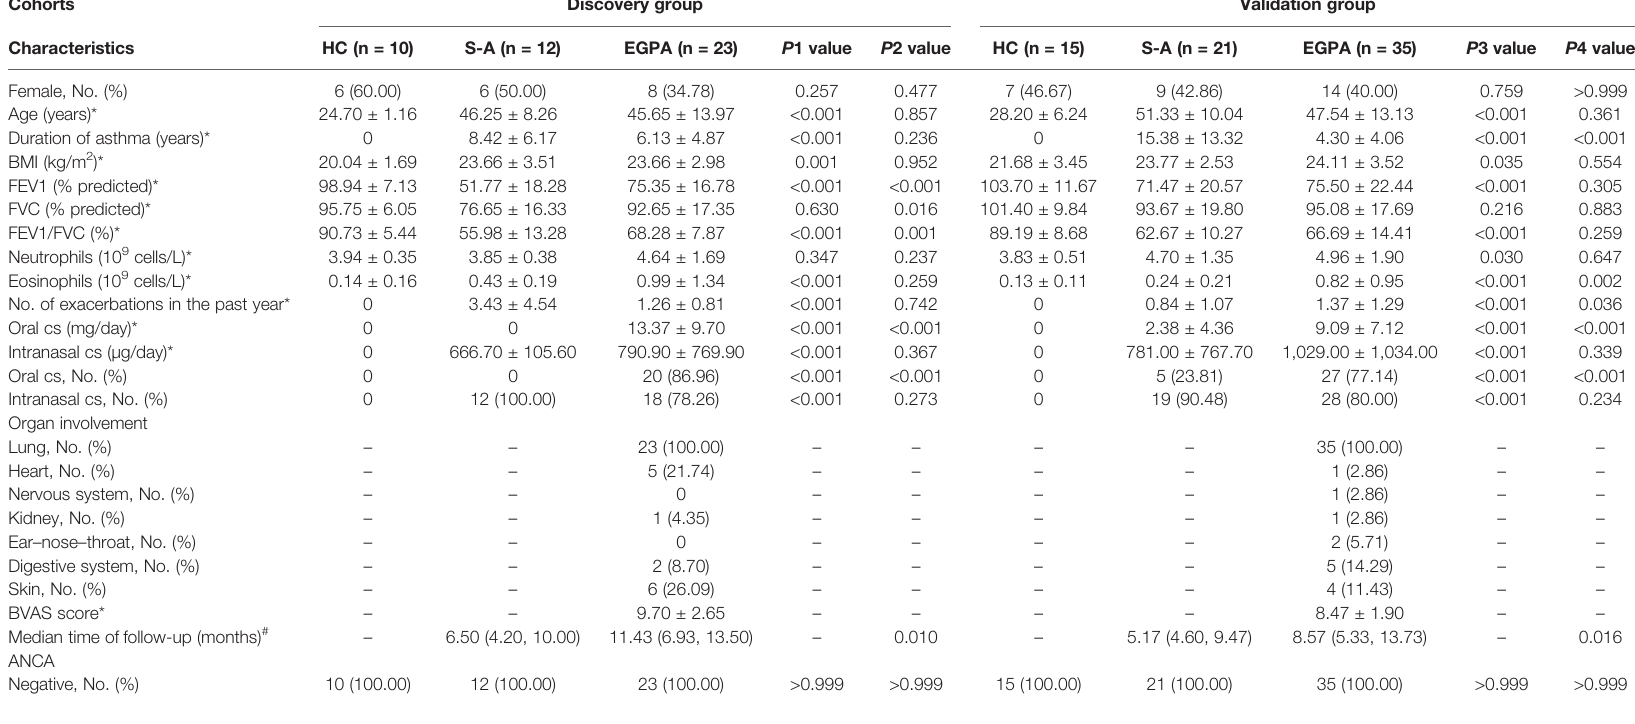
TABLE 1 | Summary of the study